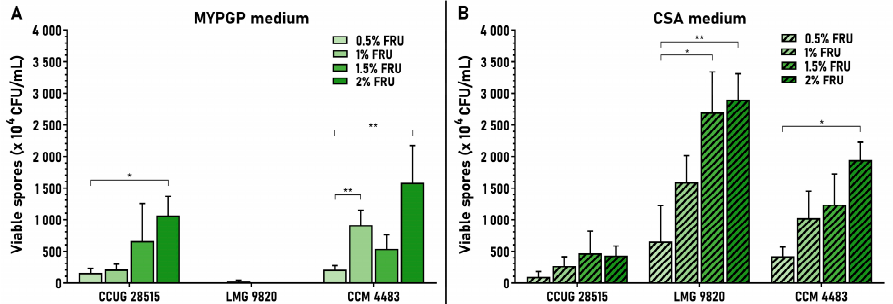
Figure 3. Effect of different fructose concentrations on sporulation of P. larvae ERIC I strains. Spore yields obtained on MYPGP or CSA plates containing 0.5–2% of fructose are depicted as the mean ± SEM. Statistical significance of data considering the yields obtained at 0.5% fructose as the control is shown (* p < 0.05, ** p < 0.01). Individual data sets represent results from 3–5 spore cultivation replicates at 0.5% and 1.5% fructose and 5–9 replicates at 1% and 2%